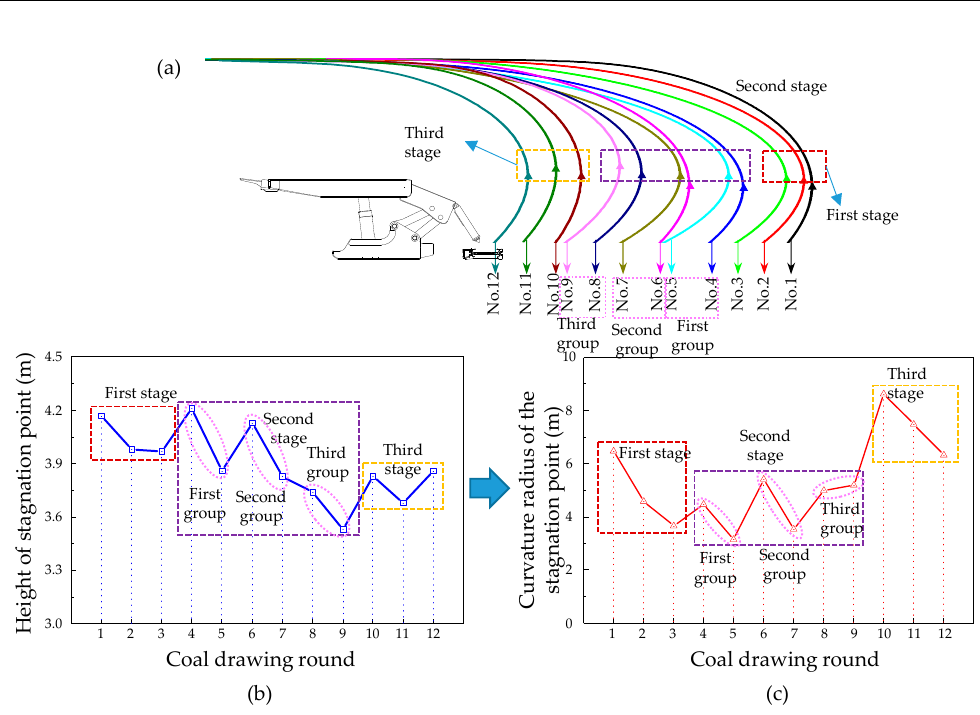
Figure 13. Fitting curves. ( a ) Fitting curve of each coal drawing round; ( b ) Evolution of height of stagnation point during coal drawing; ( c ) Evolution of curvature radius of stagnation point during coal drawing.